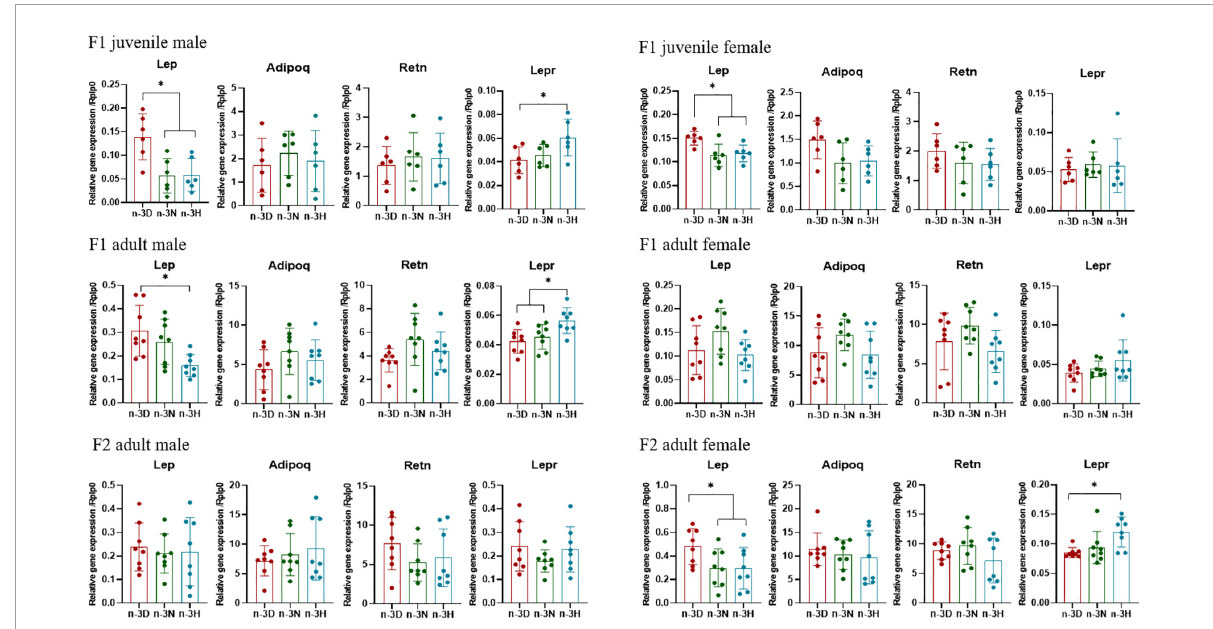
FIGURE2 Effects of paternal dietary ratio of n-6: n-3 PUFAs on the expression of Lep, Adipoq, Retn, and Lepr in the adipose tissue of offspring. The protocols for production of F1 and F2 offspring as well as the experiments were the same as those described in Figure 1 . Mice from the F1 or F2 offspring were fed normal chow diet for 16 weeks. The mRNA expression of leptin (Lep), adiponectin (Adipoq), and resistin (Retn) in the epididymal fat, as well as, Lep receptor (Lepr) in the hypothalamus, was measured using real-time qPCR. n = 6–8 mice in each group. Data have been presented as mean values with standard deviation. * P < 0.05. Statistical differences were analyzed by one-way analysis of variance with Bonferroni post hoc , or Dunnett’s T3 test for data lacking homogeneity of variance. For non-normally distributed data, the Kruskal–Wallis test was used with Mann-Whitney U post hoc